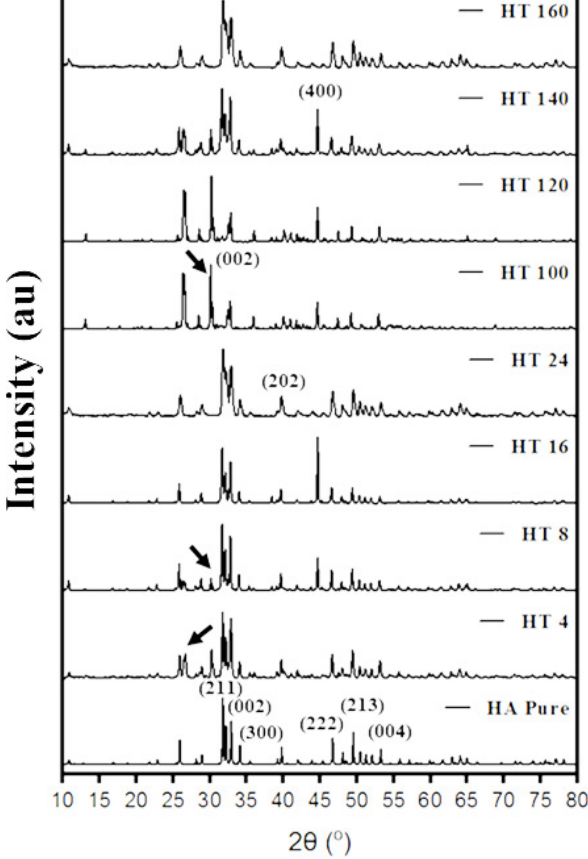
Figure 4: The comparison of the X-Ray Diffraction patterns for the formation of the nano-crystalline HA from the different reaction conditions in the hydrothermal route with respect to pure HA Table 3: The different ratios of the HA-BCZT nanocomposites pre- pared with their various sintering conditions with the correspond- ing d 33 values